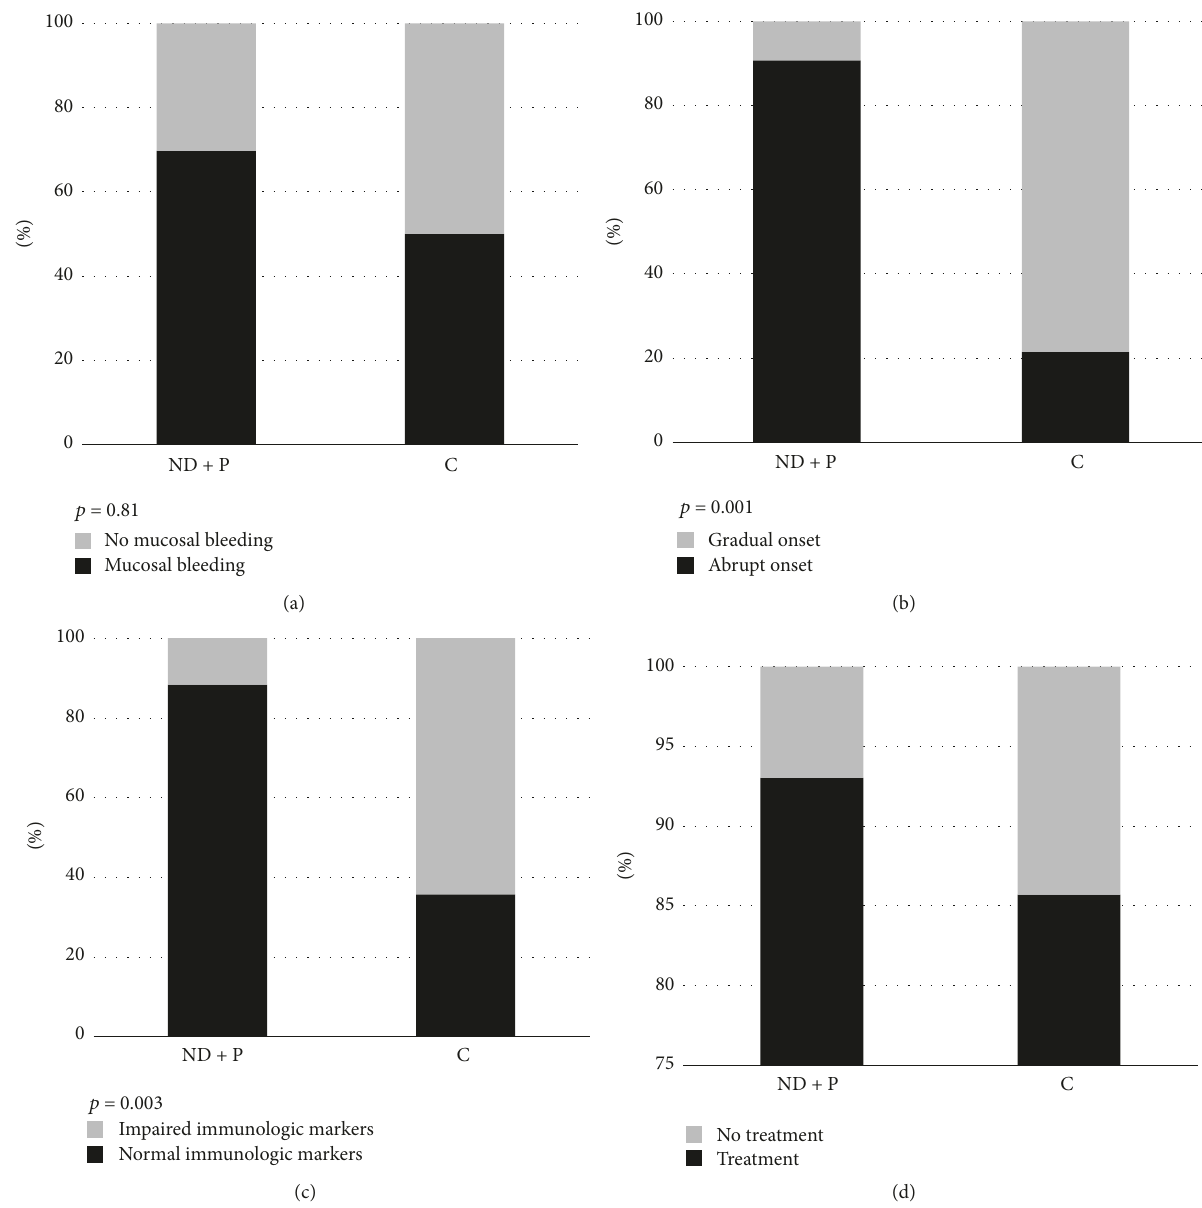
Figure 2: (a) Percentage of children with newly diagnosed/persistent (ND + P) and chronic (C) ITP with mucosal bleeding at diagnosis or not, (b) percentage of children with abrupt ( < 2 weeks) or gradual ( > 2 weeks) symptomatology before diagnosis, (c) percentage of children with normal or impaired immunological markers, and (d) percentage of children who received or did not receive treatment with intravenous immunoglobulin and/or